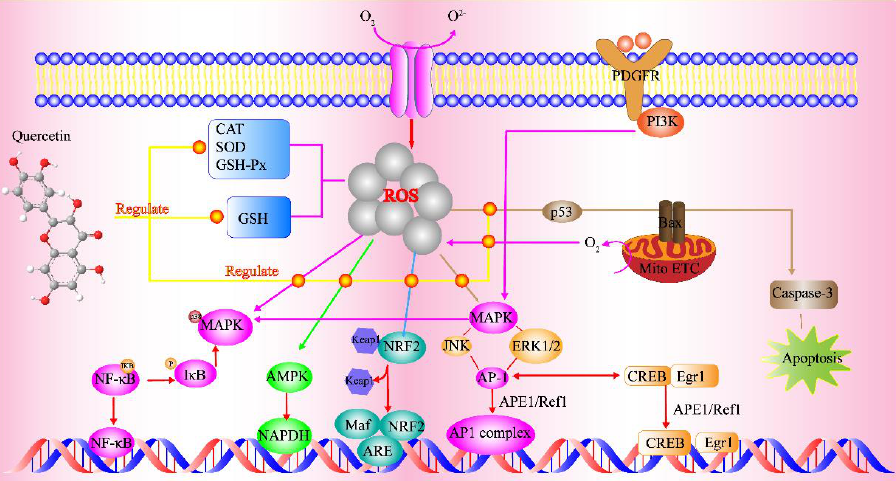
Figure 2. The antioxidant signaling pathway regulated by quercetin. Environmental factors increase the production of reactive oxygen species (ROS). The mitochondrial electron transport chain (mito ETC) is another robust source of intracellular ROS generation. Quercetin can regulate the enzyme-mediated antioxidant defense system and the non-enzyme-dependent antioxidant defense system. It can also regulate signal pathways such as NRFB, AMPK, and MAPK caused by ROS to promote the antioxidant defense system and maintain oxidative balance. ROS in turn enhance the production of APE1/Ref1 and the activation of several signaling events including p53-mediated apoptotic events, MAPK pathways, the NF-E2-related factor (NRF2)-mediated activation of genes containing antioxidant response element (ARE), and NF- κ B